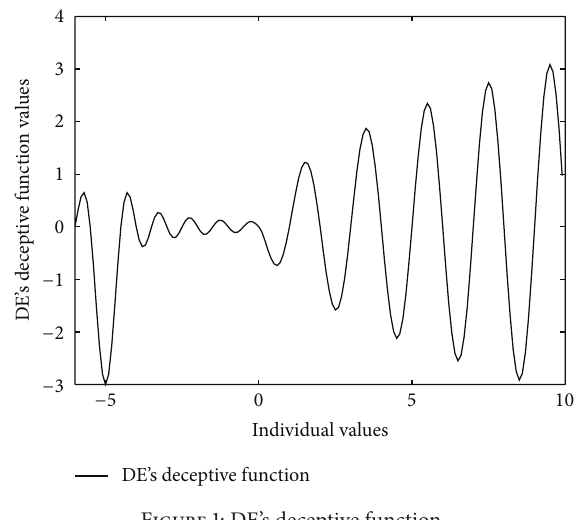
Figure 1: DE’s deceptive function.